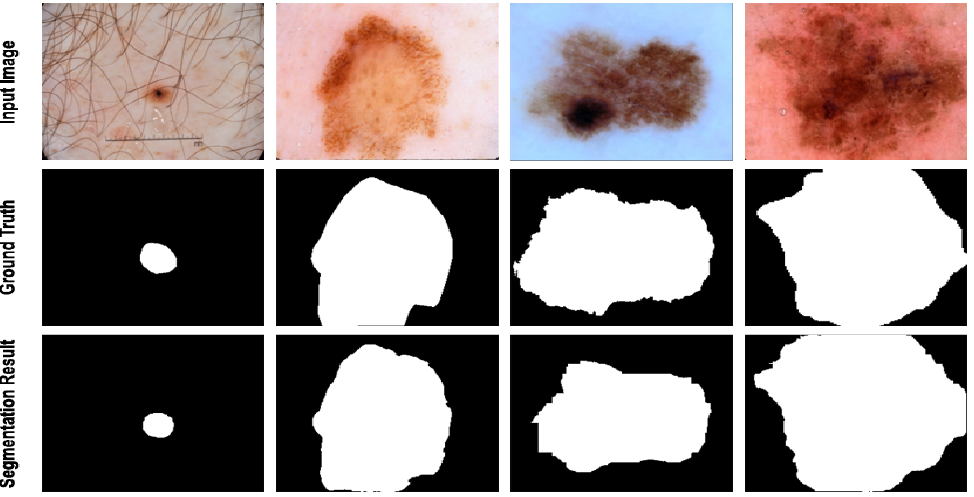
Figure 4. Segmentation results of the proposed method on ISIC 2018. The visualization shows that the proposed method learns the complex pattern of the lesion and precisely segments the abnormal regions.